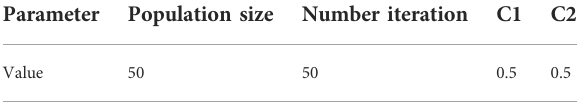
TABLE 3 Particle swarm optimization parameters.